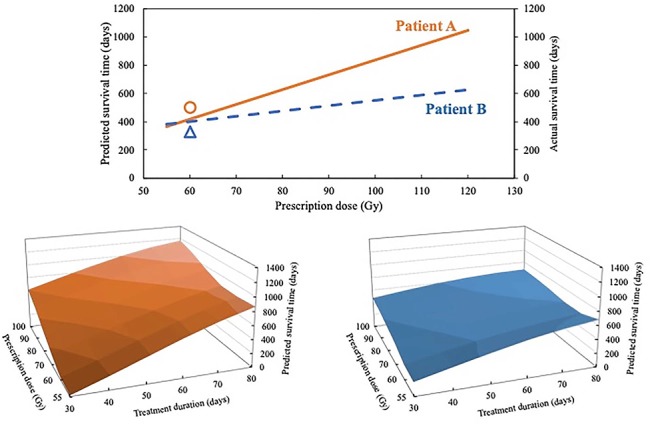
Result of investigating the change in the predicted survival time when changing prescription dose and treatment duration as input features. Top: relationship between the prescription dose and predicted survival time of each patient. The round (○) symbol shows the actual survival time and prescription dose of patient A, and the triangle (△) symbol shows the actual survival time and prescription dose of patient B. Bottom: the result of adding treatment duration of each patient.